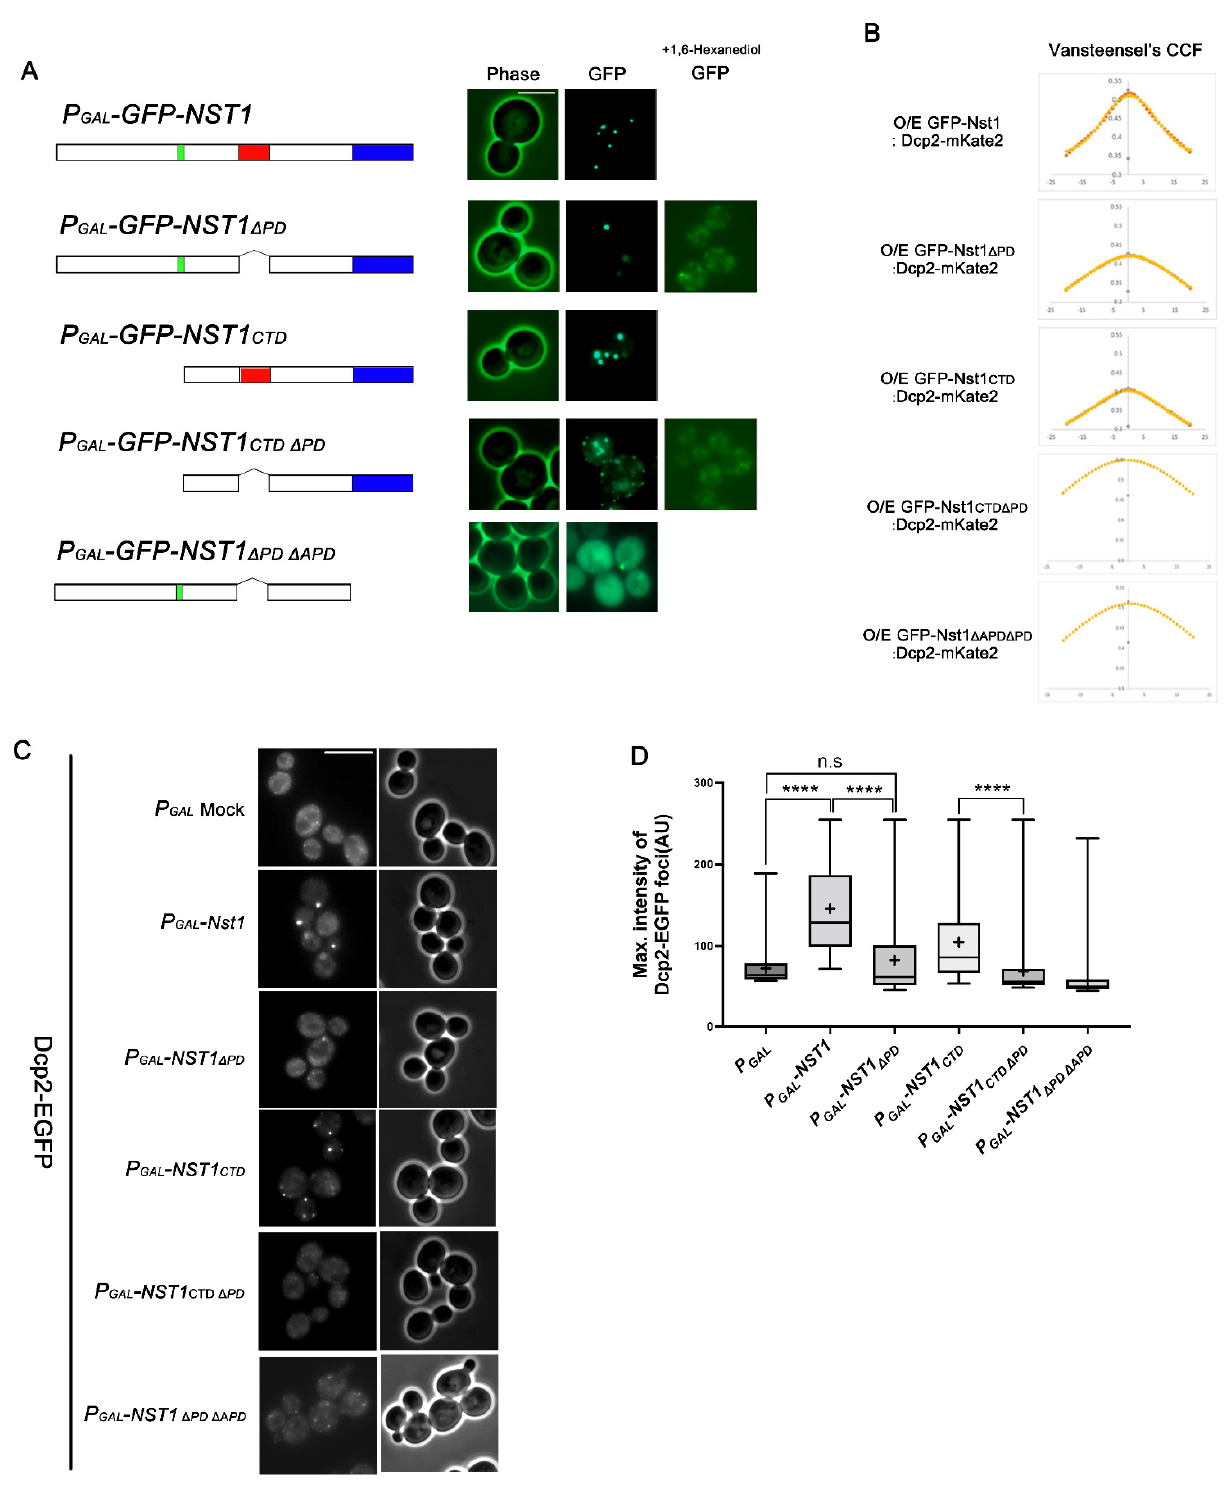
Figure 4. The polyampholyte region is not critical for Nst1 self-condensation but is responsible for inducing Dcp2 condensation. ( A ) Fluorescence microscopy of cells overexpressing EGFP-tagged full-length Nst1, Nst1 Δ PD (residues 1–630 and 753–1240), Nst1 CTD (C-terminal Nst1 residues 430–